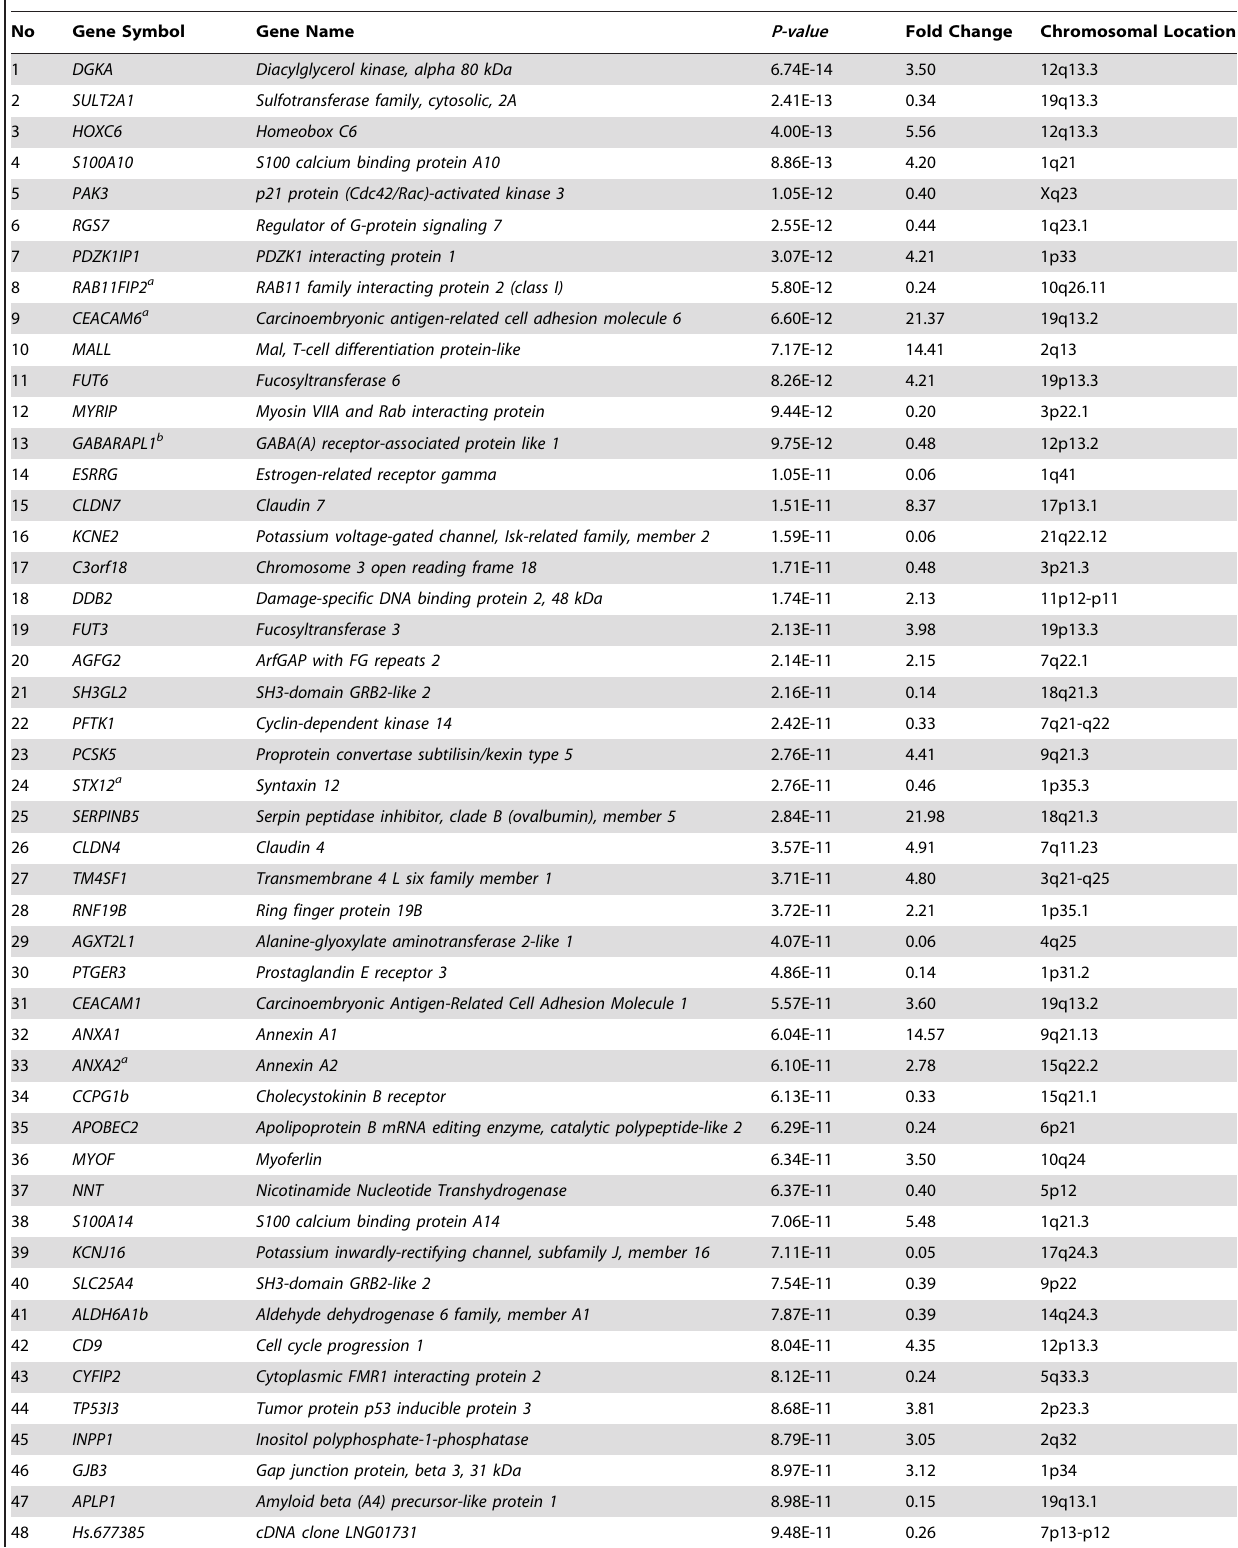
Table 3. Summary showing top 50 differentially expressed genes in BE vs NC (the complete list is reported in Table S5).